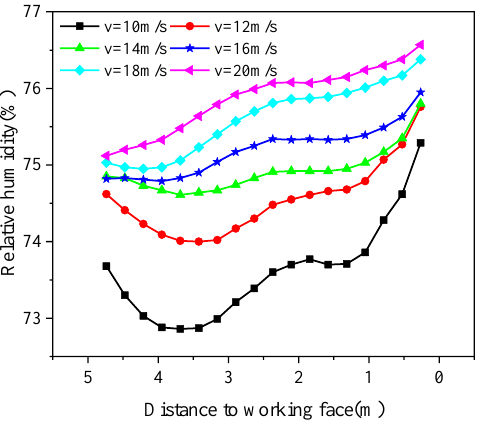
Figure 11. Relative humidity distribution of drift centerline under different air supply velocity.